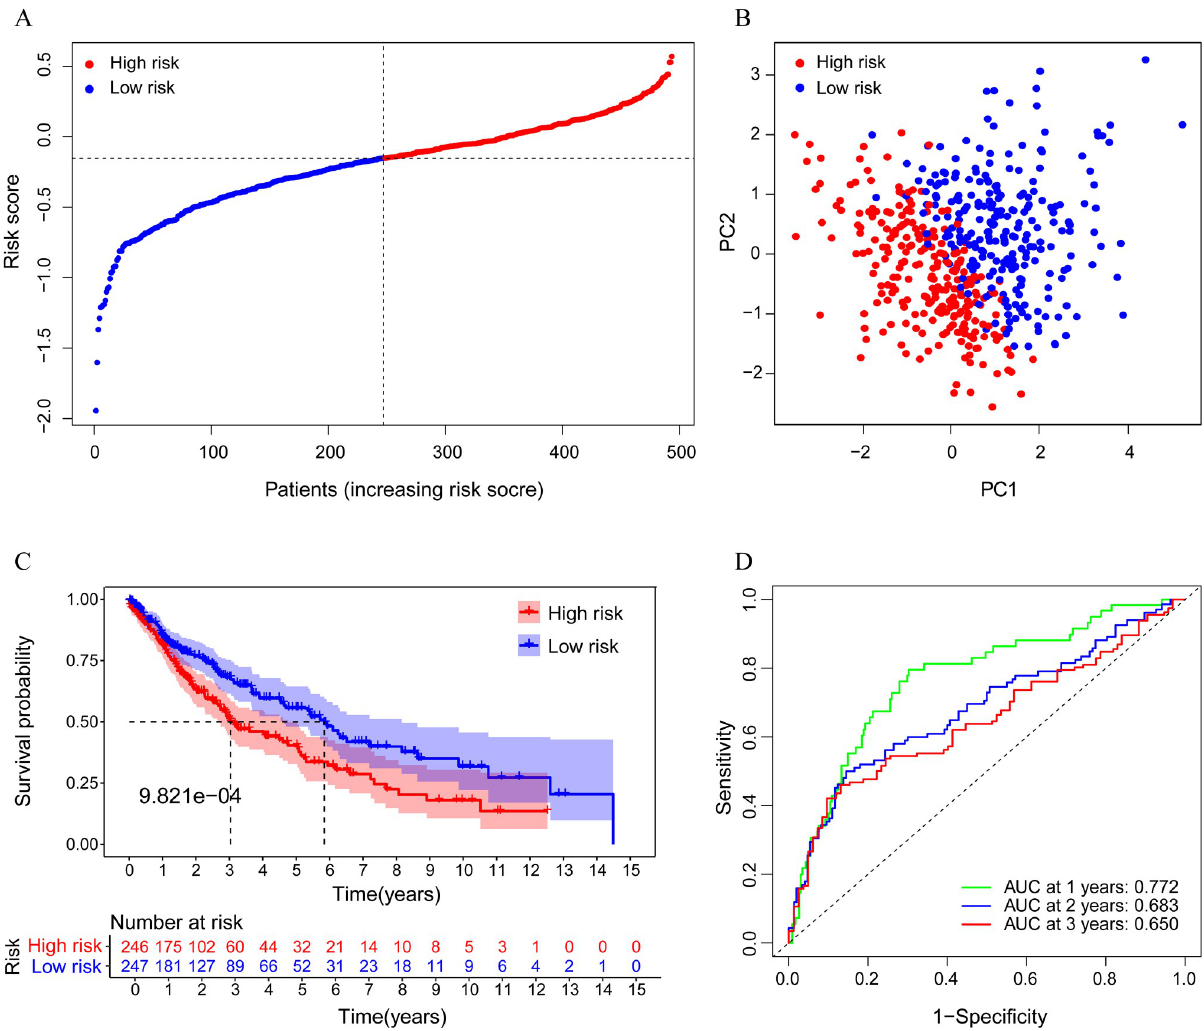
Fig 4. Prognostic analysis of the 5 gene signature model in the TCGA cohort. A. The distribution by median value of the risk scores with this model. B. PCA plot. C. Kaplan-Meier curves for the OS of patients in the high-risk group and low-risk group. D. AUC of time-dependent ROC curves verified the prognostic performance of the risk